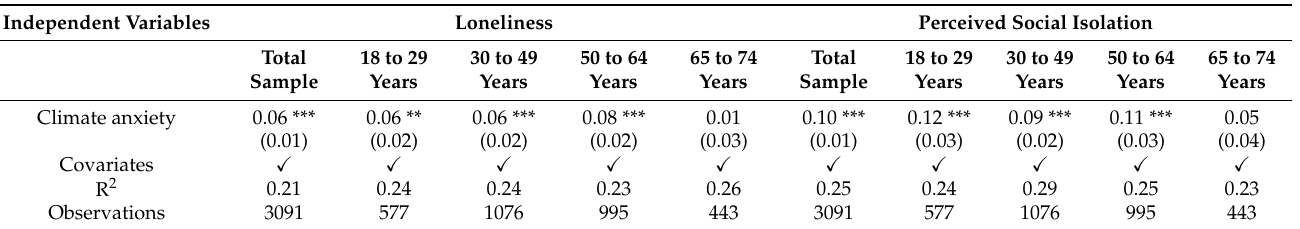
Table 2. Climate anxiety and loneliness as well as perceived social isolation (total sample and stratified by age group). Results of multiple linear